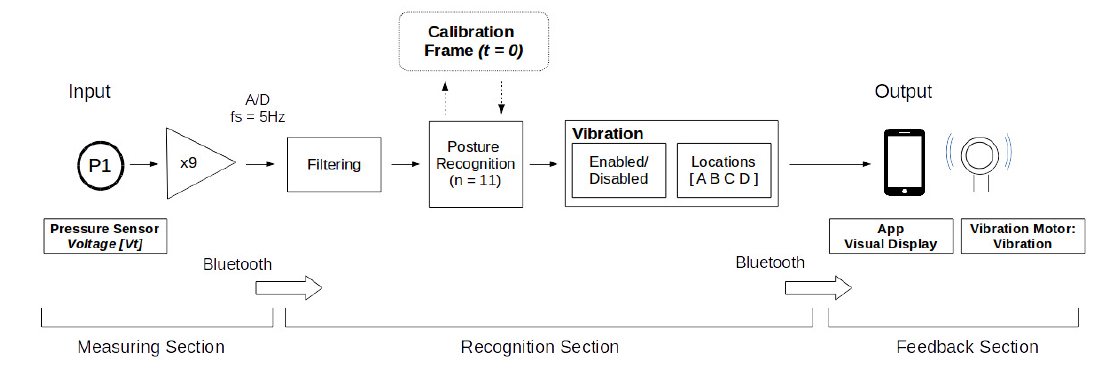
Figure 4. LifeChair data flow